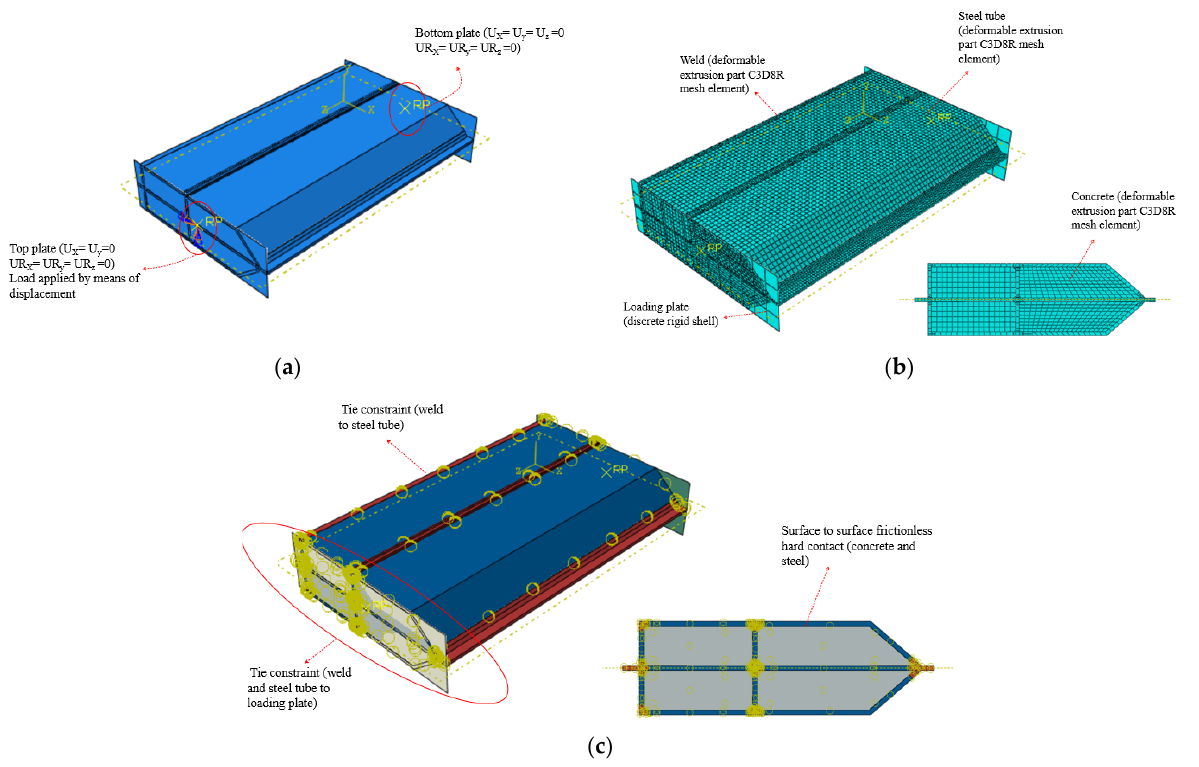
Figure 11. Detailed depiction of the constructed FEM model (PEN5 and PEN6). ( a ) Boundary conditions; ( b ) Meshing; ( c ) Interactions.